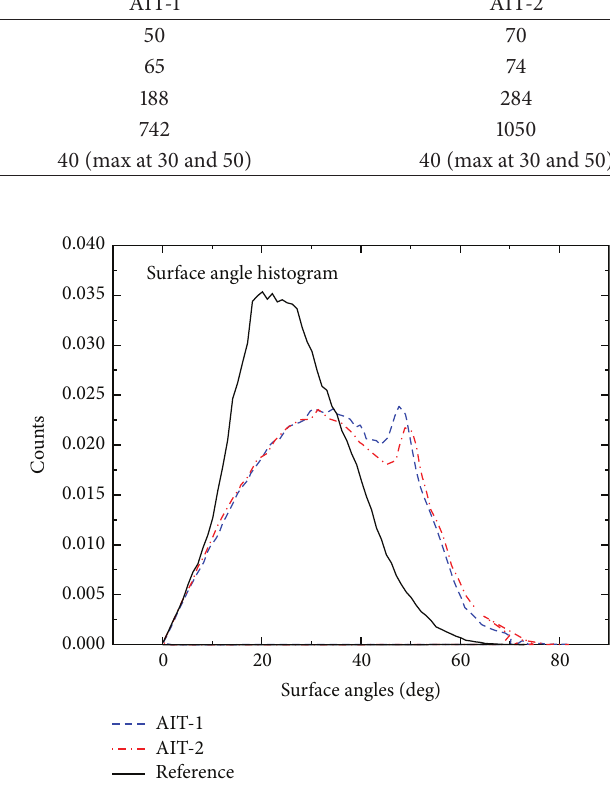
Figure 2: Determining the autocorrelation length 𝑙 for the three different superstrates used.